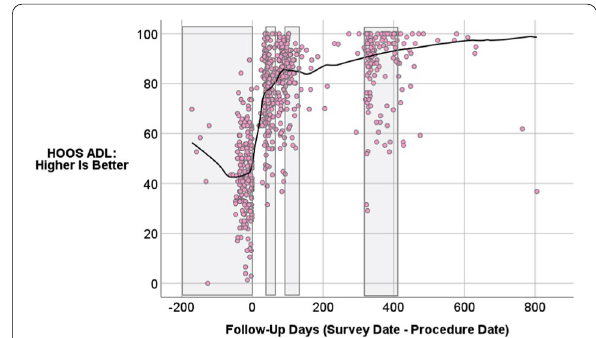
Fig. 1 Scatter plot of HOOS scores over time